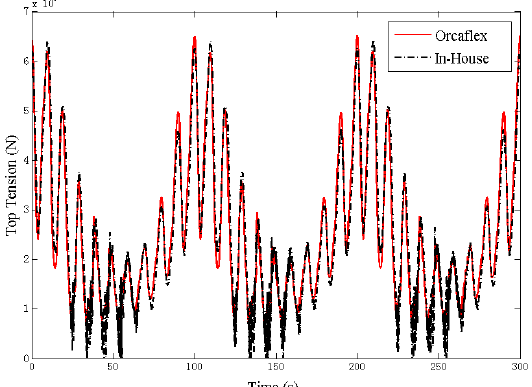
Figure 12. Multicomponent mooring line under the combined vertical and horizontal harmonic ex- citation.